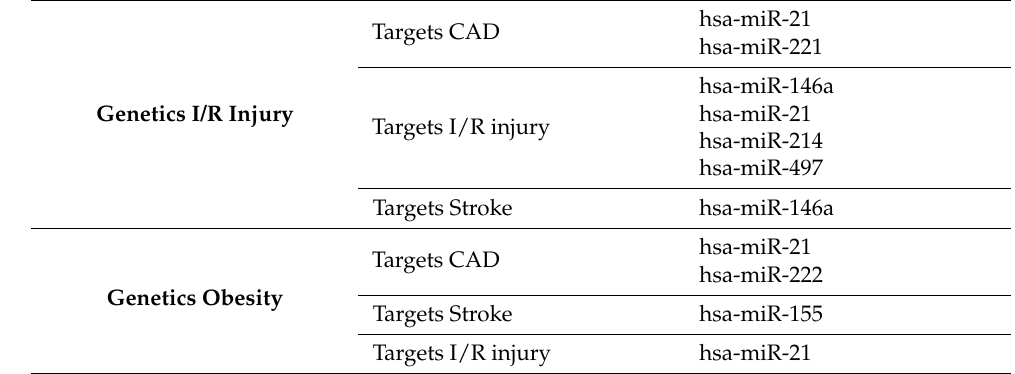
Table 1. miRNAs which are causally associated with ischemia/reperfusion injury, stroke, coronary artery disease, and obesity in humans. Eight hsa-miRs were identified using the term “genetics” as